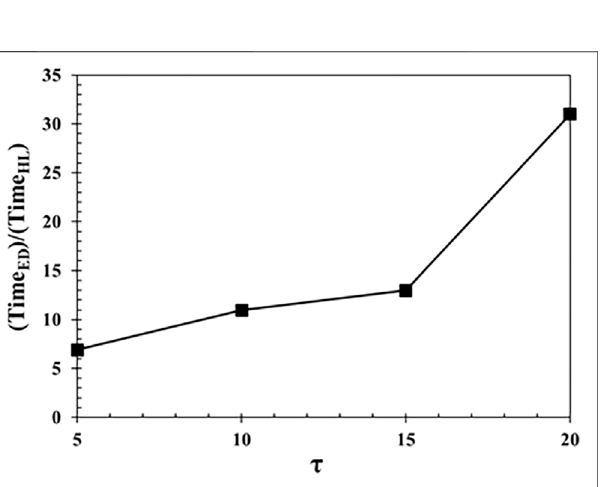
as a function of τ for the single-track HL